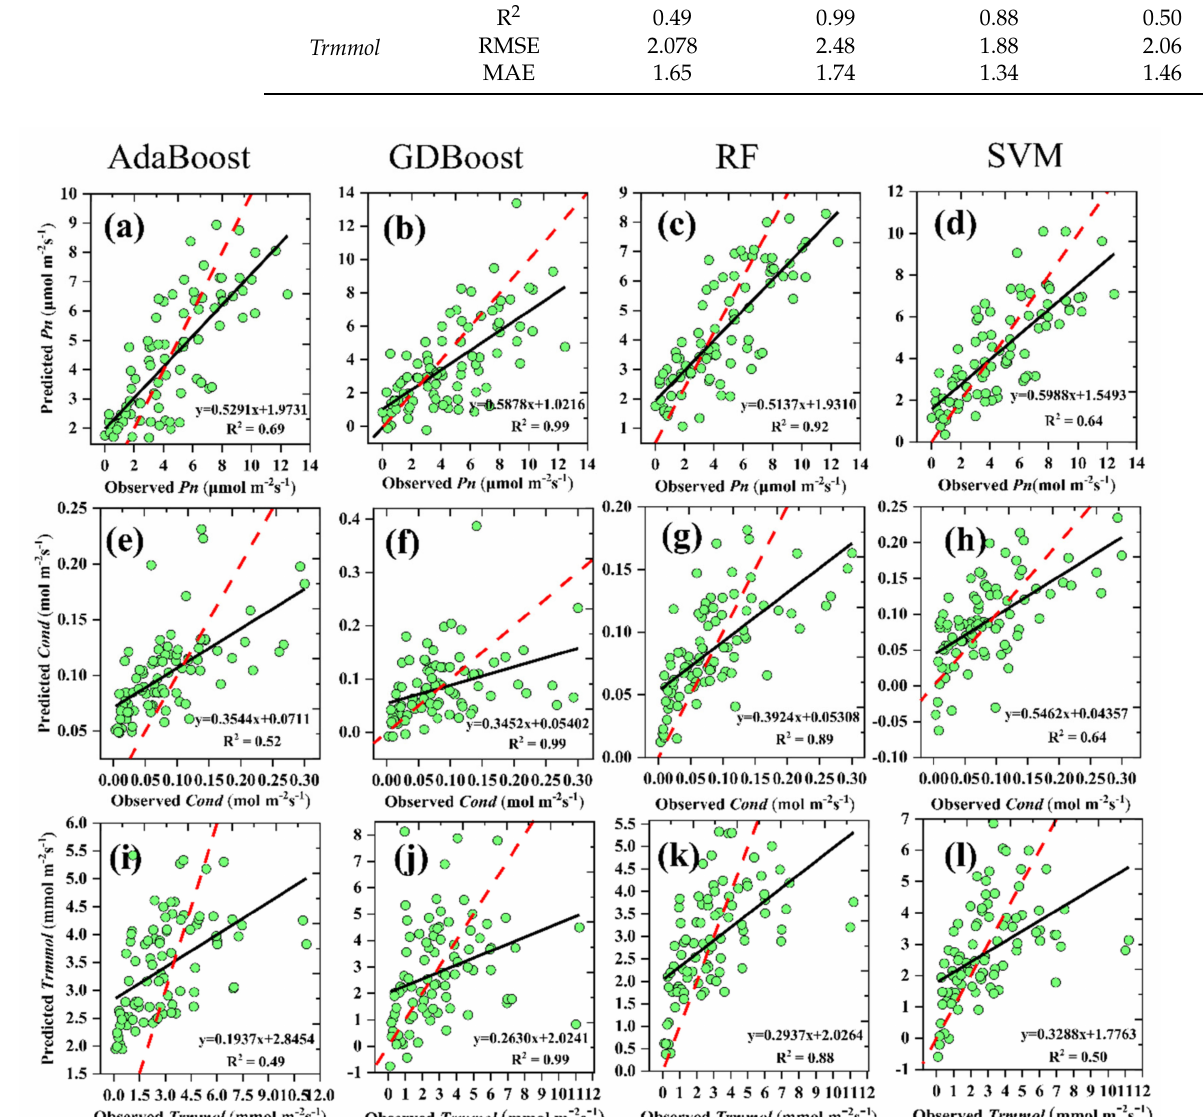
Figure 8. Measured vs. predicted values after applying AdaBoost, GDBoost, random forest (RF), and support vector machine (SVM) model to predict leaf photosynthetic CO 2 assimilation rate ( Pn in µ mol m − 2 s − 1 ), leaf stomatal conductance ( Cond in mol m − 2 s − 1 ), and leaf transpiration rate ( Trmmol in µ mol m − 2 s − 1 ). The red line is the 1:1 line, and the black line is fitting line between observed and predicted values. ( a – l ) represents Pn –AdaBoost, Pn –GDBoost, Pn –RF, Pn –SVM, Cond